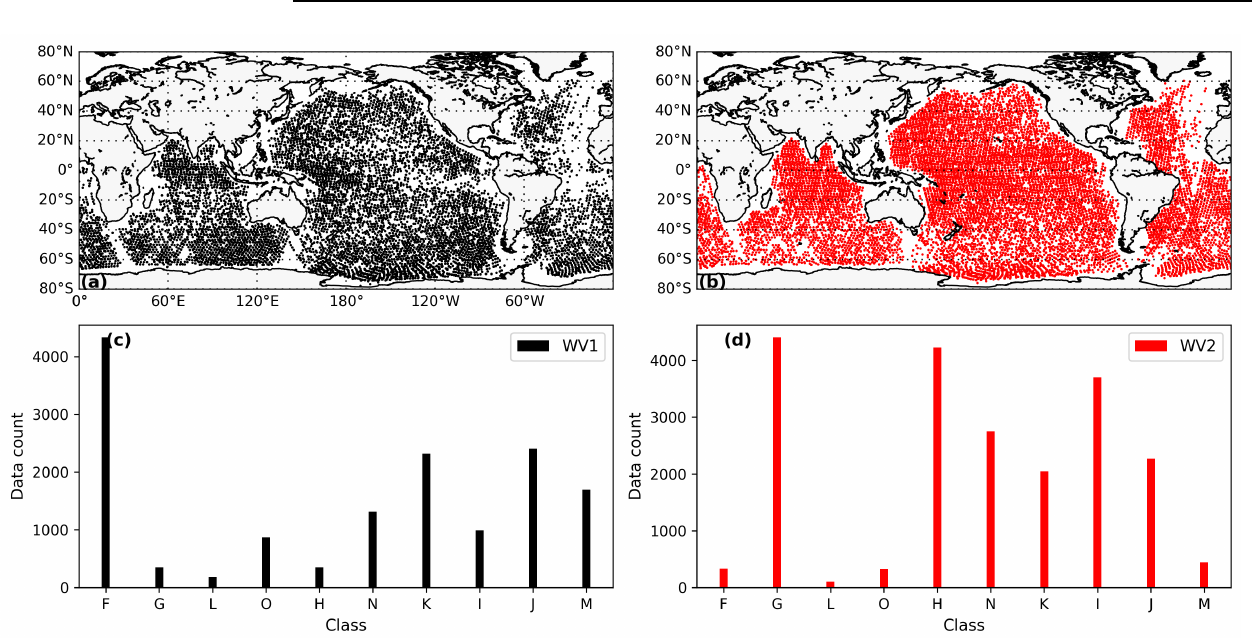
Figure 1. Global distribution of the TenGeoP–SARwv data set for all classes at ( a ) WV1 and ( b ) WV2. Individual data counts of labeled SAR images for each class at ( c ) WV1 and ( d ) WV2. Symbols corresponding to each class are referred to in Table